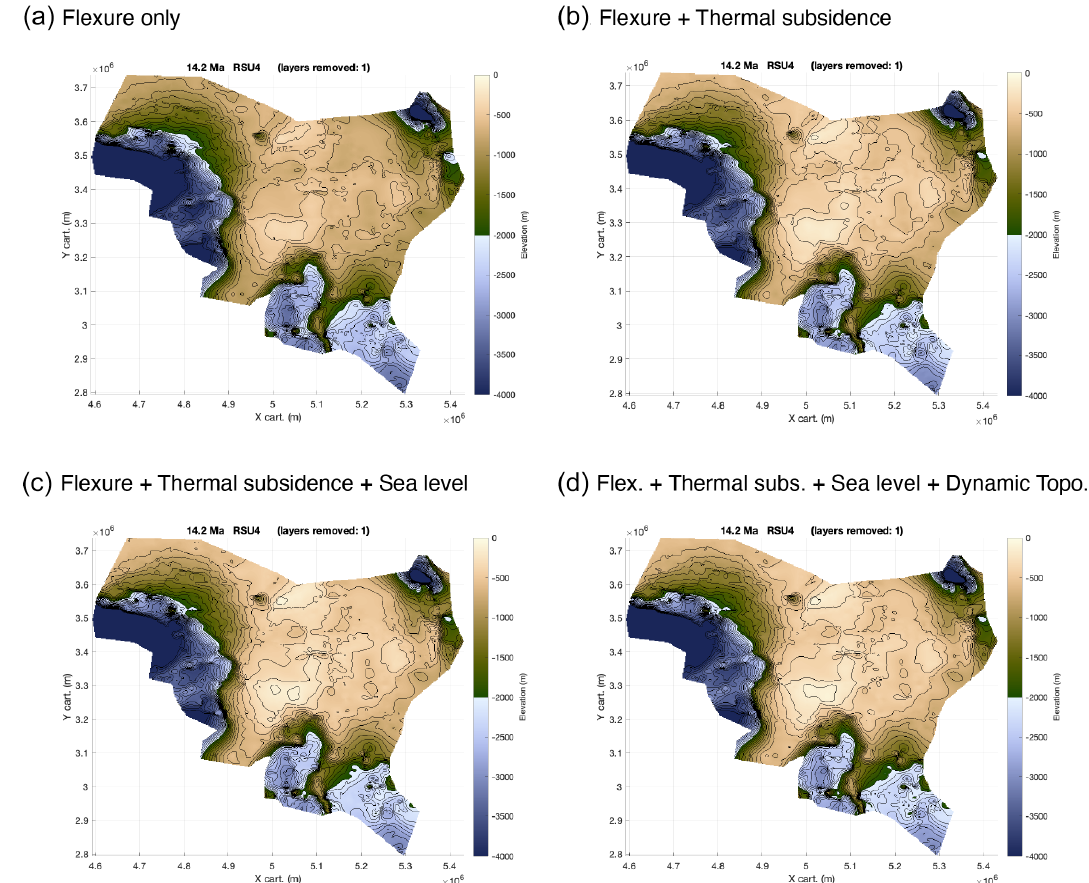
Figure 11. Backtracked mid-Miocene bathymetries at about 14Ma. The same as Fig. 10 but using flexural isostasy with spatially variable lithospheric effective elastic thickness from Chen et al. (2018). Layout is from the PALEOSTRIP plotting GUI; the colour scale is the default colour scale implemented within PALEOSTRIP and has been saturated below − 4000m and above 200m for this figure. The island located in the uppermost right corner is the only location with elevation above sea level. Note that the colour scale is colour-blind friendly and is from Crameri et al. (2020). PALEOSTRIP has implemented 12 different colour scales, and 9 out of 12 are colour-blind friendly. For all parameters used in these examples, see Table A1 in Appendix